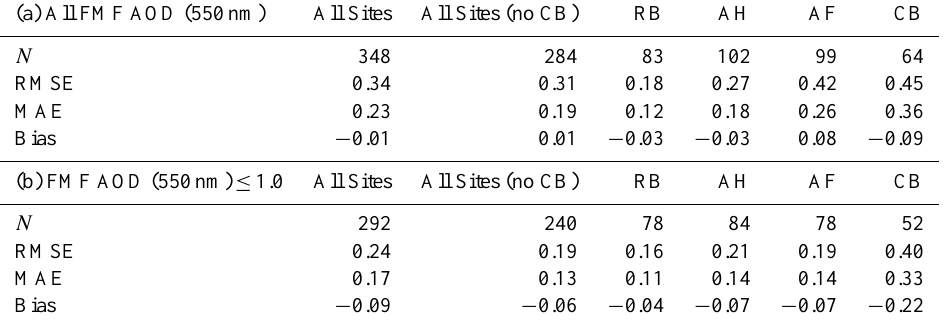
Table 2. Statistics from comparison between model-calculated aerosol optical depth (AOD) and AERONET fine mode fraction (FMF) AOD. (a) All FMF AOD 550nm conditions; (b) only for FMF AOD 550nm ≤ 1 . 0. Root-mean-square error (RMSE), the mean absolute error (MAE), and the mean bias